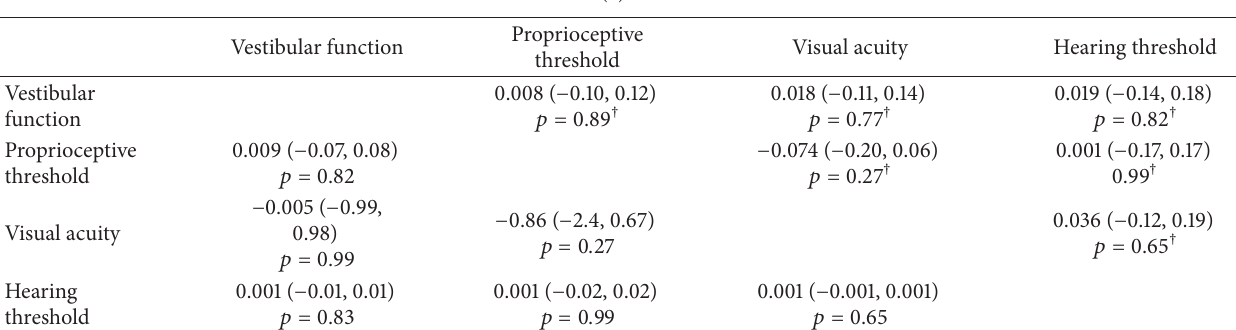
regression coefficients corresponding to bottom half of table. 95 % confidence intervals are included in parentheses. The units for the variables are vestibular function (VOR gain ratio), proprioceptive threshold (degrees), visual acuity (LogMAR), and hearing threshold